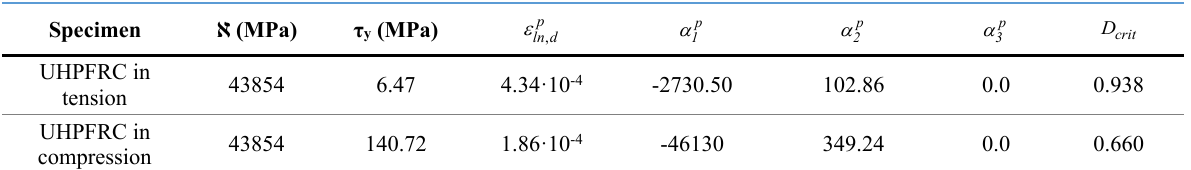
Table 2. Material data for the mean FLHB model of